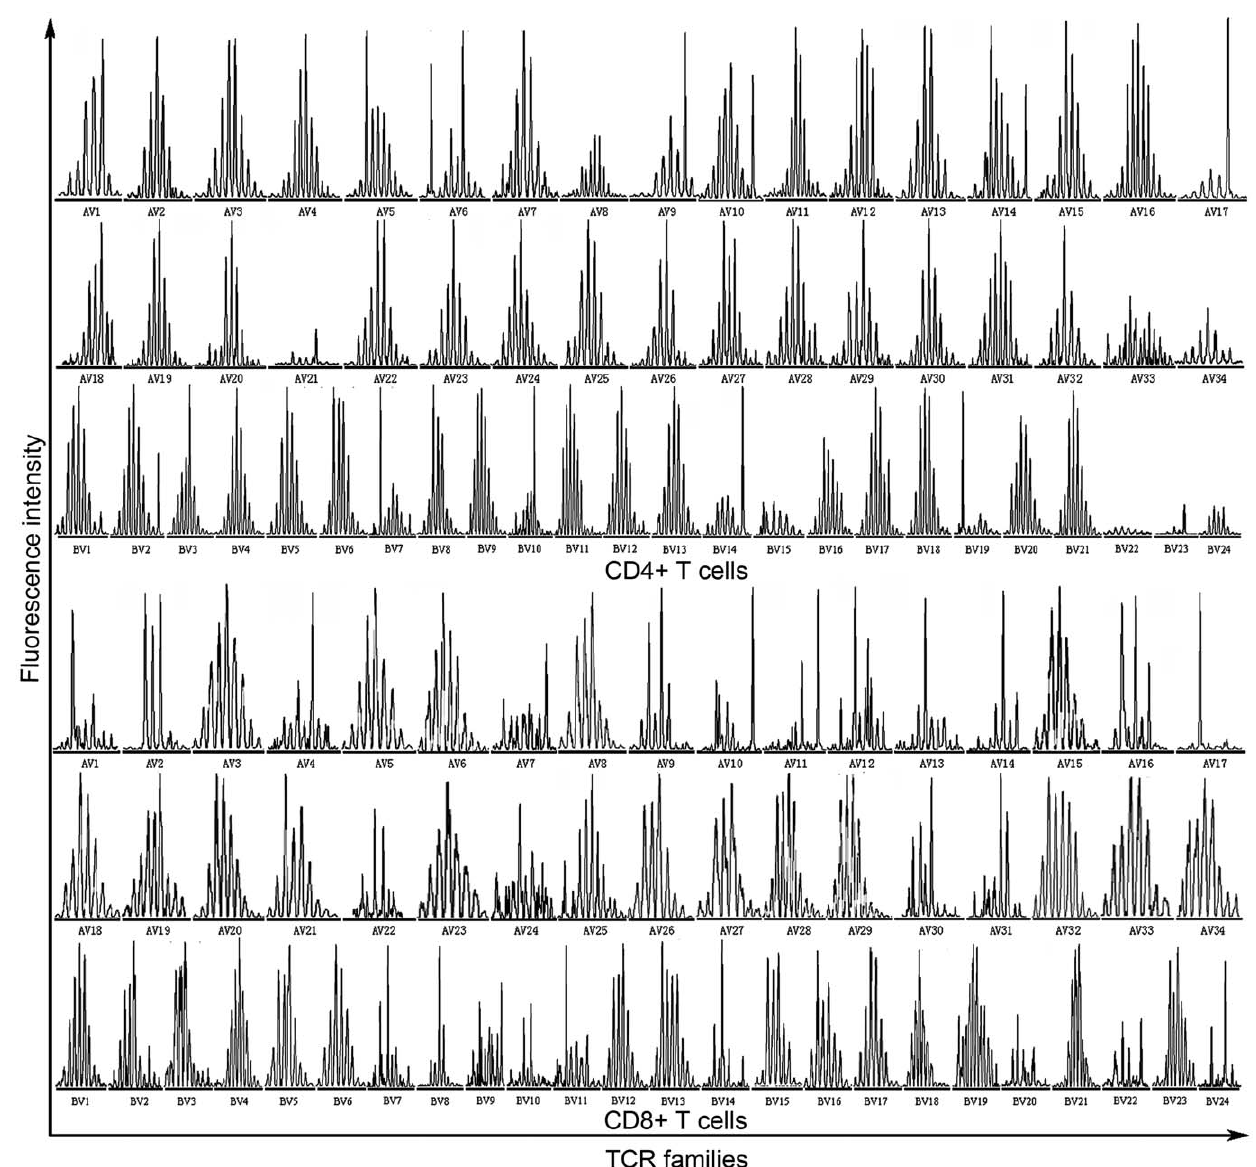
Figure 3. CDR3 spectratypes of TCR families in CD4 + /CD8 + T cells in TB patient-47 (moderate group).